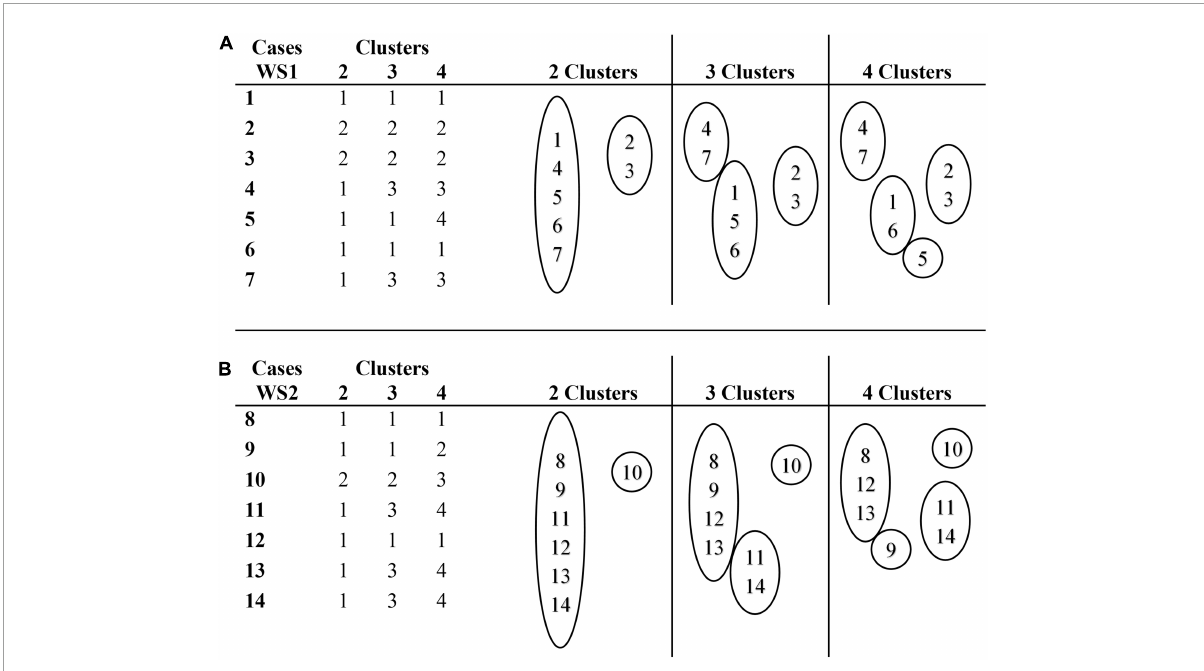
FIGURE7 Cluster membership for a range of solutions (2, 3, and 4 clusters) for substitution processes. (A) Cluster membership of cases in WS1 group. (B) Cluster membership of cases in WS2